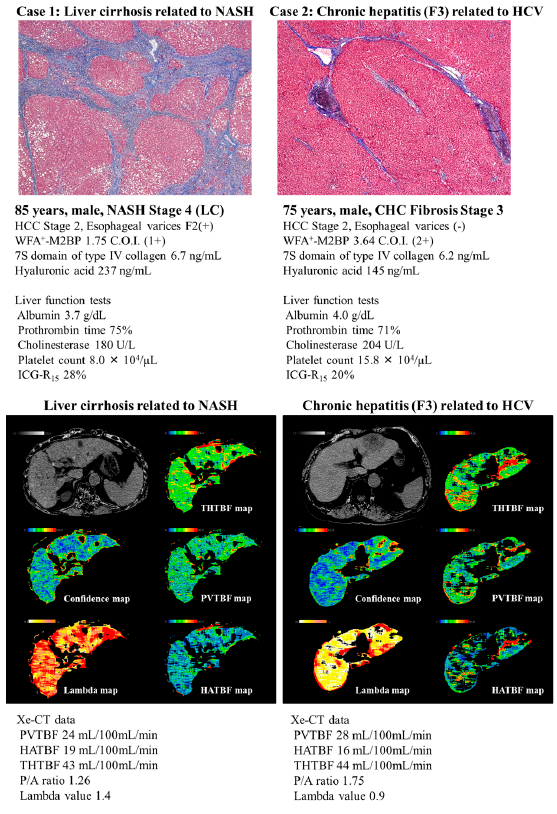
Figure 3. Cases of advanced fibrosis stage in NASH and CHC. Figure 3 shows cases of the advanced fibrosis stage in NASH and CHC. An 85-year-old Japanese man (case 1) was pathologically diagnosed with Stage 4 NASH (Brunt’s classification [23]). His clinical features were also obviously LC-like (e.g., thrombocytopenia, hepatocellular carcinoma, and esophagogastric varices). His fibrosis markers were increased to reflect advanced liver fibrosis. A 75-year-old Japanese man (case 2) was pathologically diagnosed with stage 3 CHC (Desmet’s classification [24]). In case 2, TBF was evaluated in the whole liver excluding the region of hepatocellular carcinoma. The WFA + -M2BP of the NASH-LC case was significantly lower than that of the CHC case. TBF was evaluated in both cases. PVTBF and the P/A ratio are lower in NASH-LC (case 1) than in CHC (case 2).